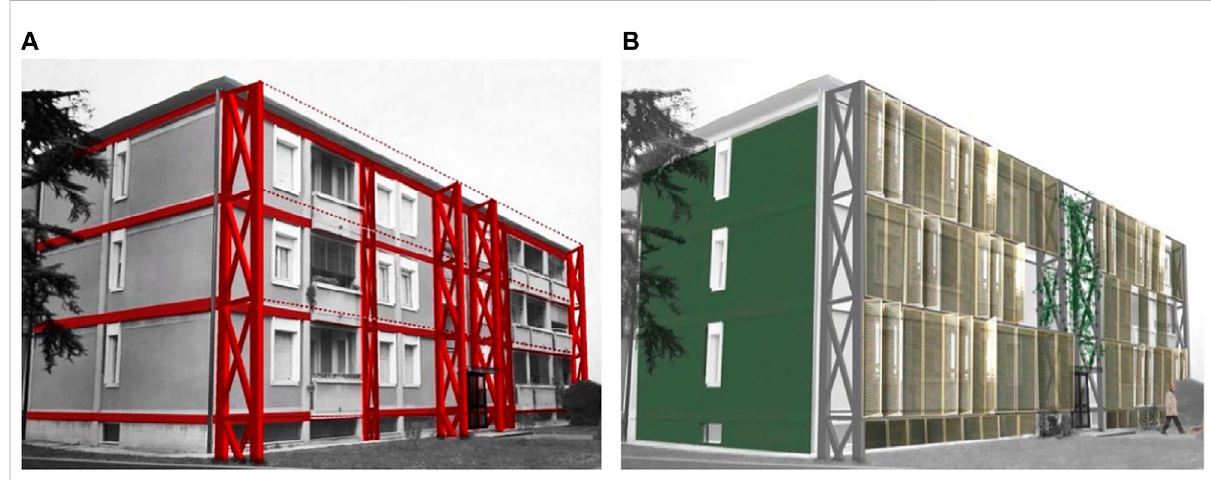
FIGURE 2 Application of a steel exoskeleton system for integrated seismic and energy refurbishment of buildings: (A) external structure for seismic retro fi tting; (B) façade systems for energy ef fi ciency and aesthetic renovation (Marini et al.,